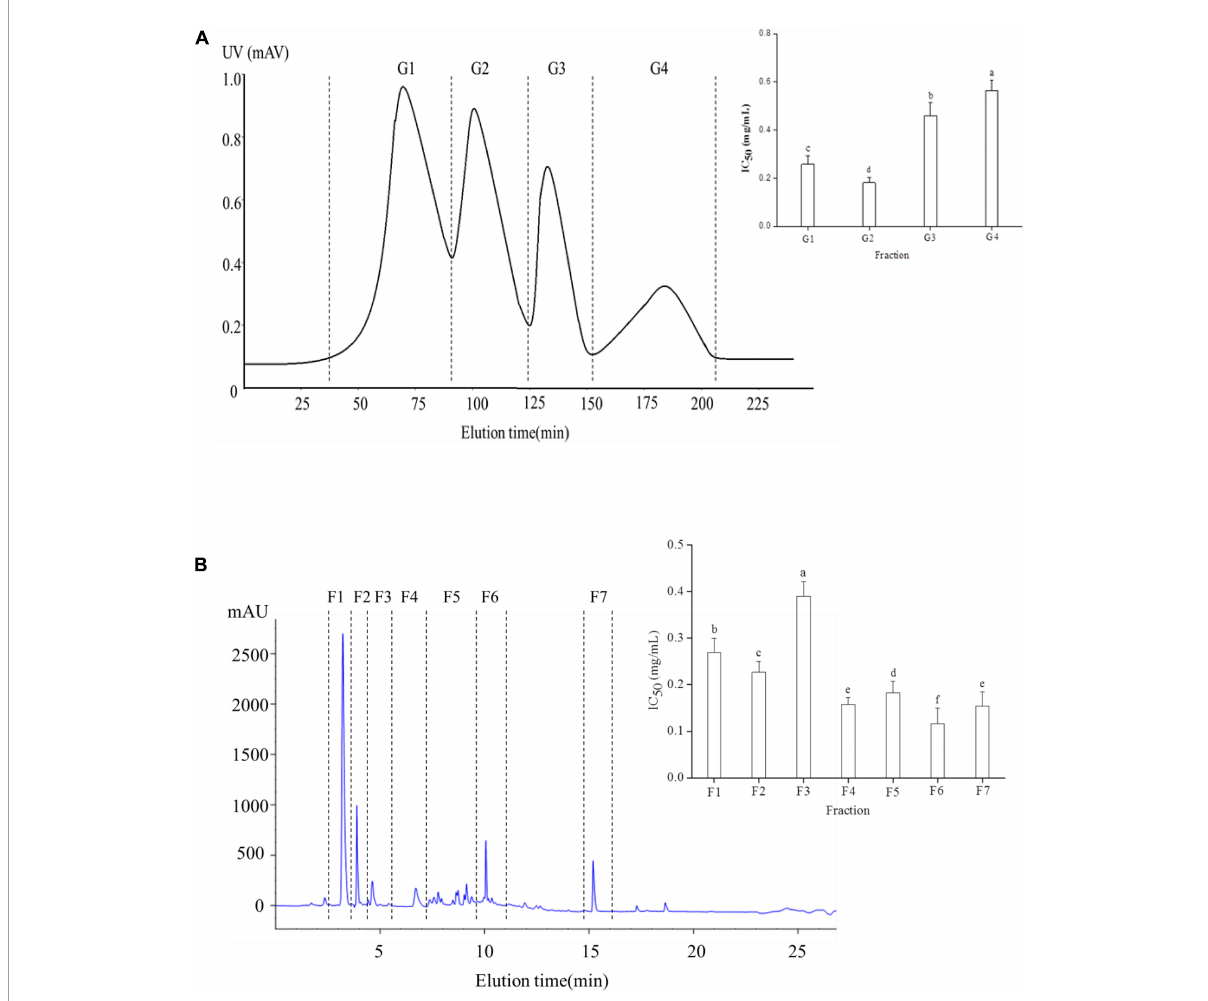
FIGURE1 Separation and purification of a novel ACE inhibitory peptide. (A) Sephadex G-25 column chromatography separation diagram of Yak bone hydrolysate. (B) The fraction G2 purified using RP-HPLC. Different letters indicate significant differences in peptide activity ( p <